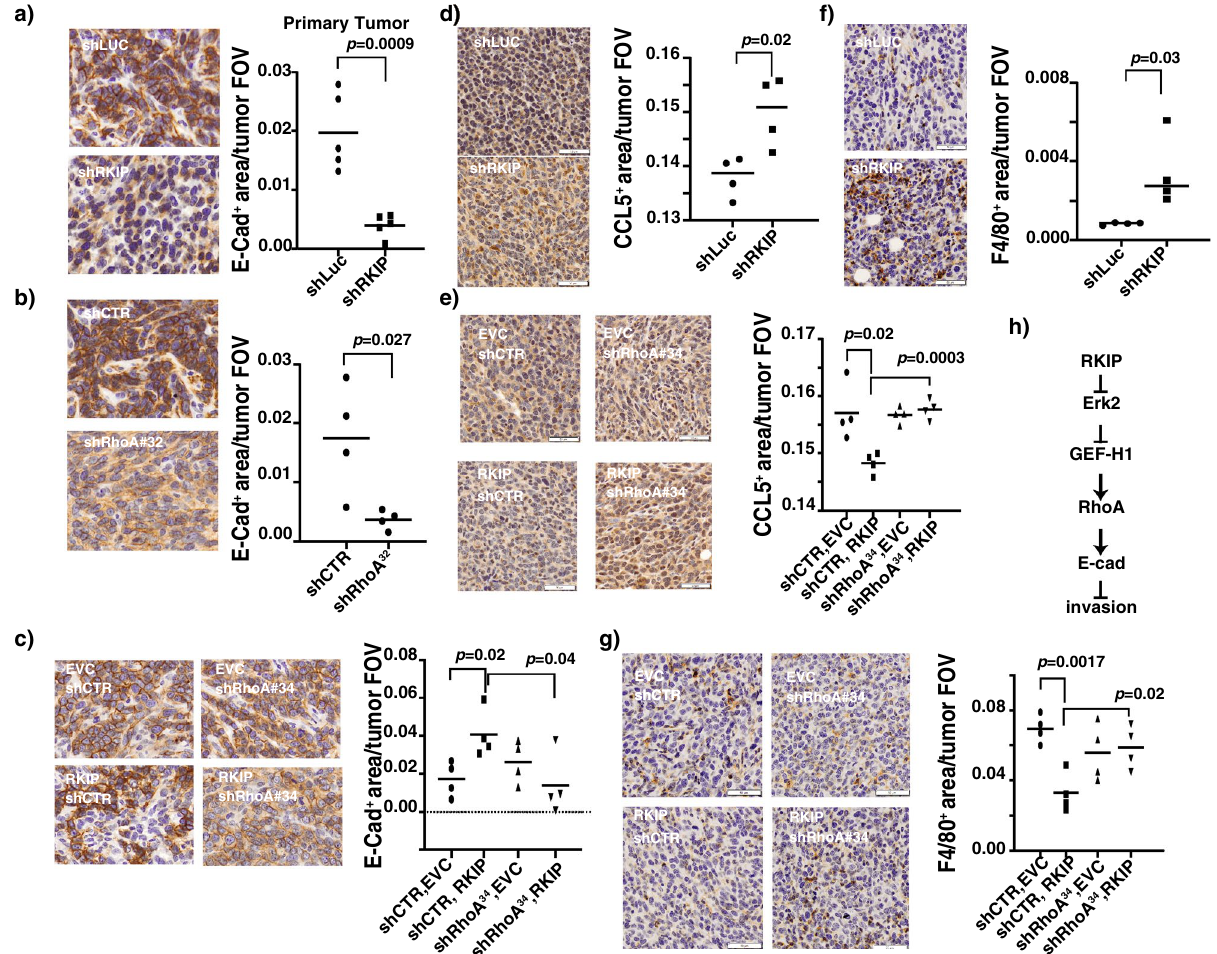
Figure 7. RKIP suppresses breast cancer metastasis in part through downstream RhoA-regulated mechanisms. ( a ) (Right panel) Representative immunohistochemical (IHC) E-cad Ab staining images of breast primary tumor sections of mice orthotopically injected with control knockdown (shLUC) or RKIP (shRKIP) knockdown 4T1 gfp-luc cells. (Left panel). Quantification of areas per tumor field of view (FOV) stained positive in the right panel for E-cad. n = 4. ( b ) (Right panel) Representative immunohistochemical (IHC) E-cad Ab staining images of breast primary tumor sections of mice orthotopically injected with control knockdown (shCTR) or RhoA (shRhoA#32) knockdown 4T1 gfp-luc cells. (Left panel). Quantification of areas per tumor field of view (FOV) stained positive in the right panel for E-cad. n = 4. ( c ) (Right panel) Representative immunohistochemical (IHC) E-cad Ab staining images of breast primary tumor sections of mice orthotopically injected with 4T1 gfp-luc cells with different combinations of control knockdown, RhoA knockdown (shRhoA#34), empty vector control (EVC) or RKIP expression. (Left panel). Quantification of areas per tumor field of view (FOV) stained positive in the right panel for E-cad. n = 4. ( d ) (Right panel) Representative immunohistochemical (IHC) CCL5 Ab staining images of breast primary tumor sections of mice orthotopically injected with control knockdown (shLUC) or RKIP (shRKIP) knockdown 4T1 gfp-luc cells. (Left panel). Quantification of areas per tumor field of view (FOV) stained positive in the right panel for CCL5. n = 4. ( e ) (Right panel) Representative immunohistochemical (IHC) CCL5 Ab staining images of breast primary tumor sections of mice orthotopically injected with 4T1 gfp-luc cells with different combinations of control knockdown, RhoA knockdown (shRhoA#34), empty vector control (EVC) or RKIP expression. (Left panel). Quantification of areas per tumor field of view (FOV) stained positive in the right panel for CCL5. n = 4. ( f ) (Right panel) Representative immunohistochemical (IHC) F4/80 Ab staining images of breast primary tumor sections of mice orthotopically injected with control knockdown (shLUC) or RKIP (shRKIP) knockdown 4T1 gfp-luc cells. (Left panel). Quantification of areas per tumor field of view (FOV) stained positive in the right panel for F4/80. n = 4. ( g ) (Right panel) Representative immunohistochemical (IHC) F4/80 Ab staining images of breast primary tumor sections of mice orthotopically injected with 4T1 gfp-luc cells with different combinations of control knockdown, RhoA knockdown (shRhoA#34), empty vector control (EVC) or RKIP expression. (Left panel). Quantification of areas per tumor field of view (FOV) stained positive in the right panel for F4/80. n = 4. Unpaired Student’s t-test (two-tailed) was used for all analyses with p < 0.05 considered significant. ( h ) A schematic depicts the mechanism through which RKIP activates E-cad to suppress cancer cells